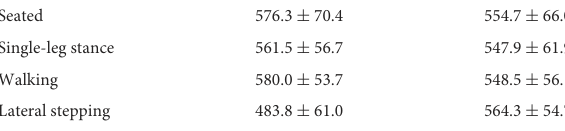
TABLE 2 Means and standard deviations for inverse efficiency index flanker variable for all motor conditions before and after exercise.